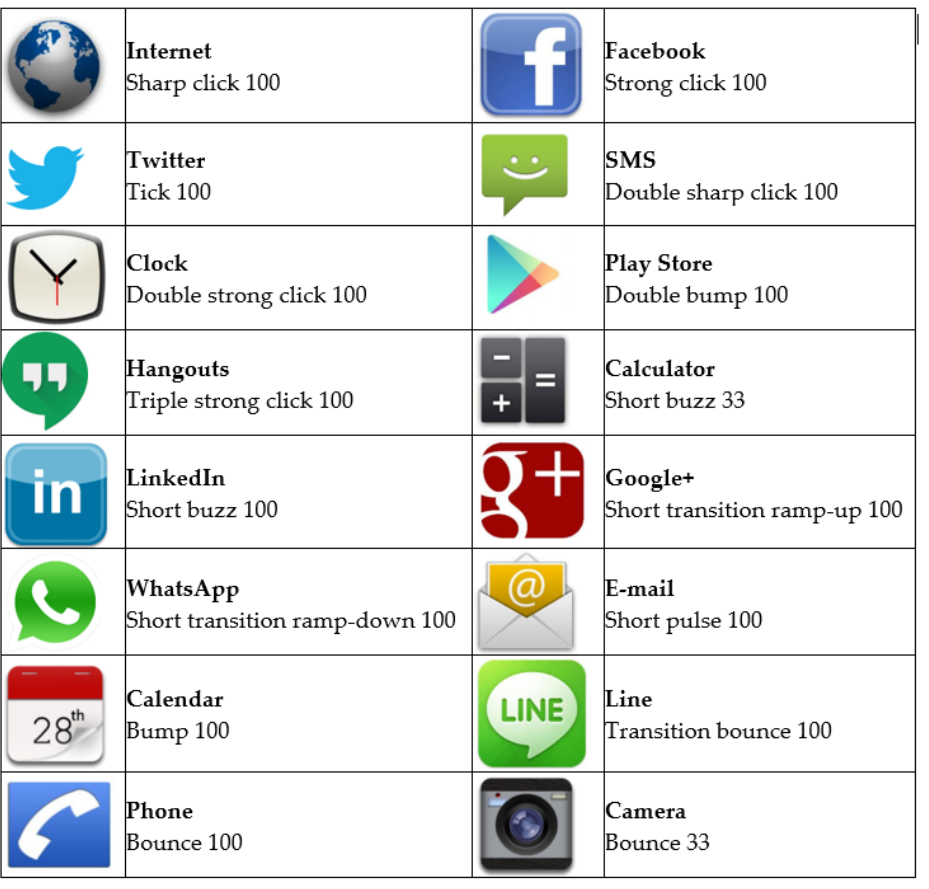
Figure 1. Haptic icons and their related vibrations. The vibrations have been chosen from the Haptic Effect Preview application. The numbers represent the vibration intensities as percentages with 100 being the maximum vibration intensity.